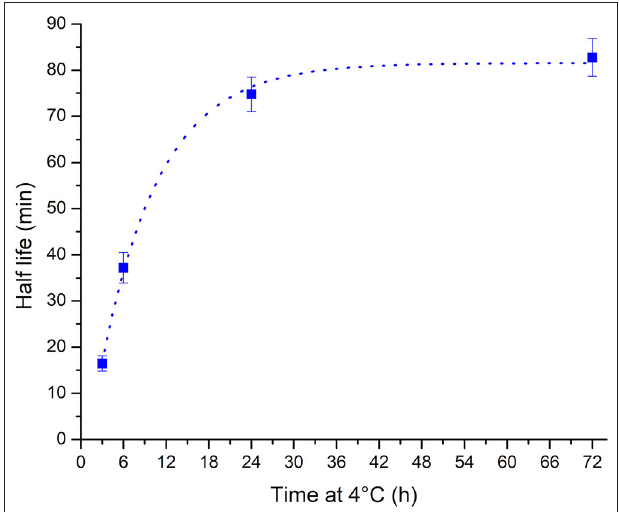
FIGURE 3 | Plot of half-life vs. storage time at 4 ◦ C showing that the half-life increases with increasing length of time at low temperature. The relationship is well fitted to a one phase exponential growth function (dotted